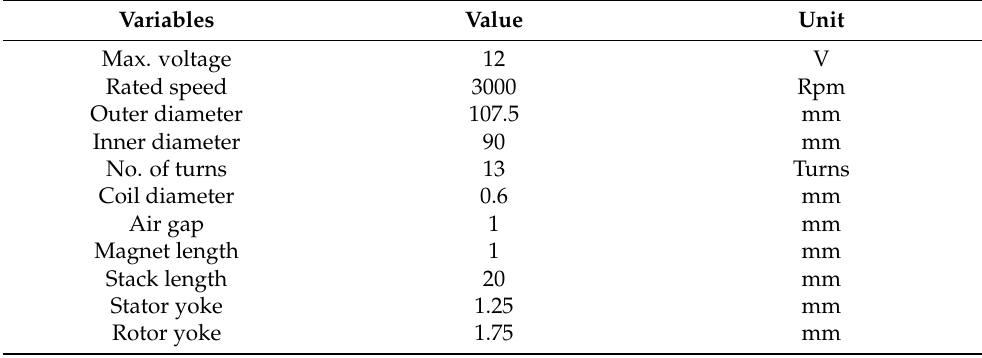
Table 2. Motor specifications for the rotating motor.